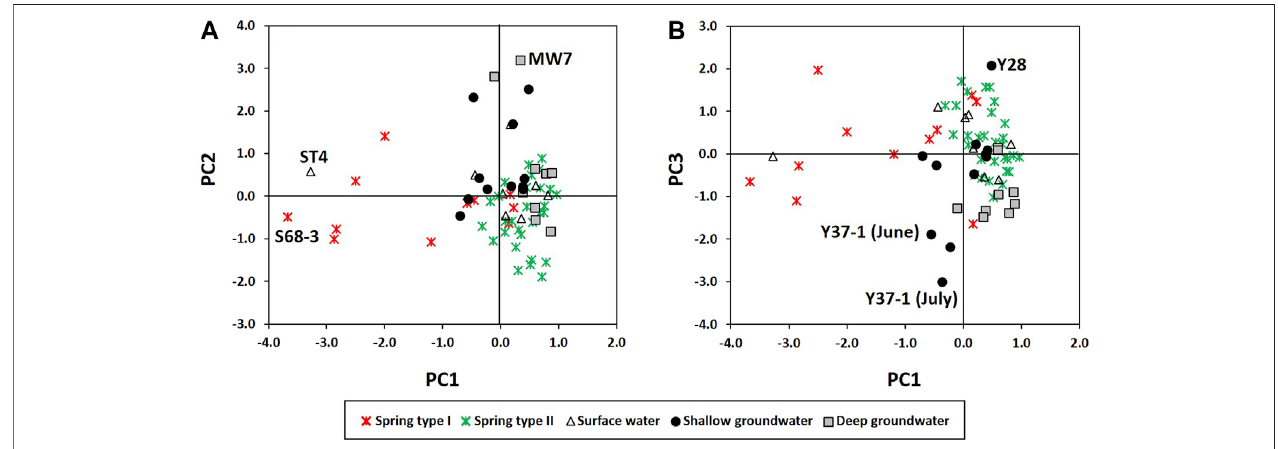
FIGURE9| Principalcomponentanalysis: (A) scoresofPC1vs.PC2; (B) scoresofPC1vs.PC3.Thelettersonthediagramindicatethenamesofdistinctsamples.